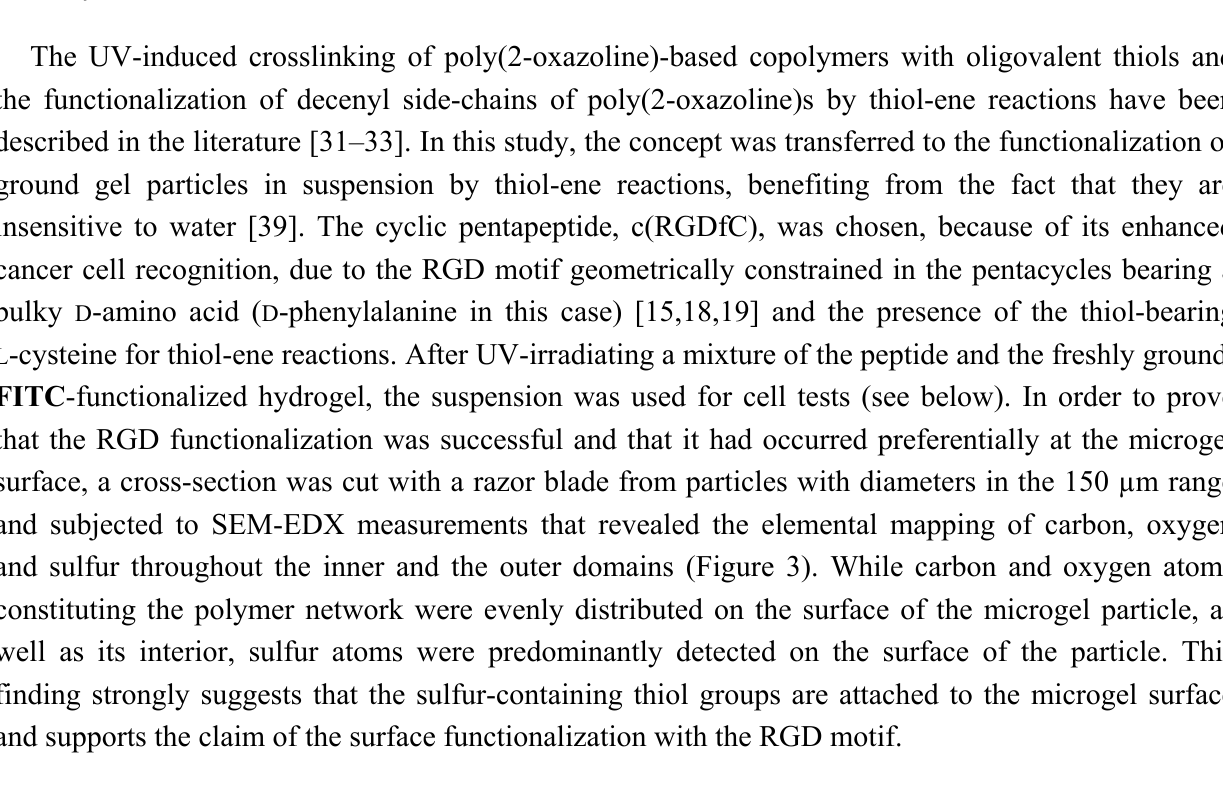
-p Dc = Ox -p TMBO gels that were 100 50 6